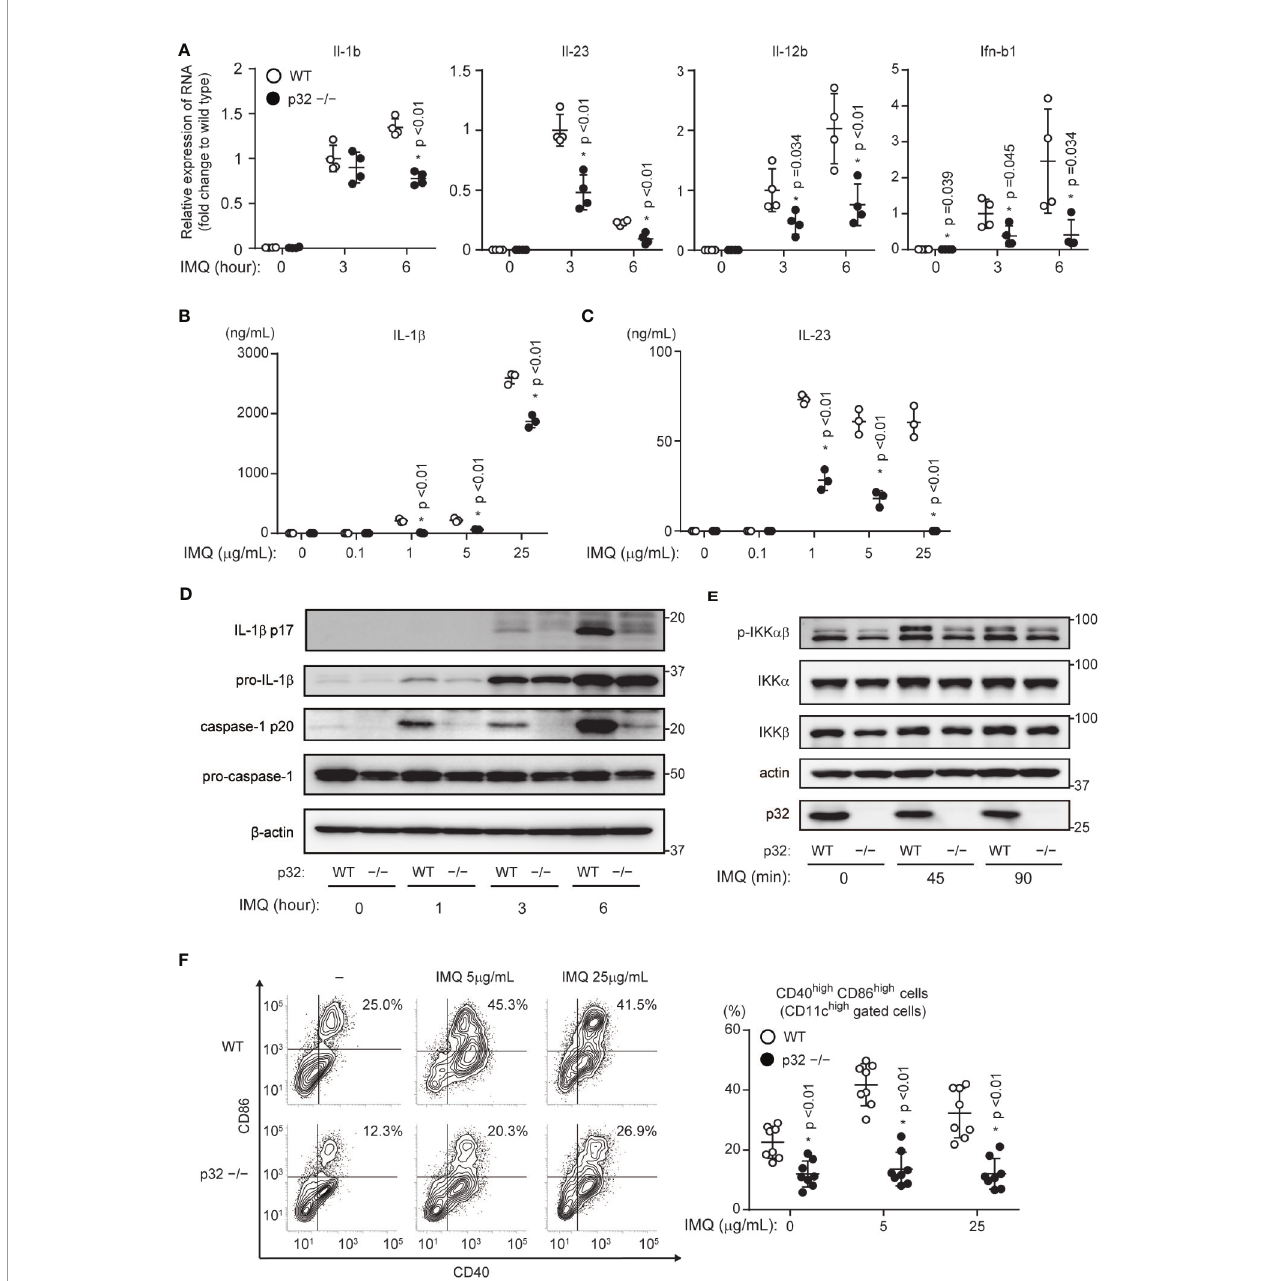
FIGURE 3 | Roles of p32/C1qbp in vitro . (A) Real-time PCR analyses of Il-1b, Il-23, Il-12b, and Ifnb1 expression levels in WT and p32 − / − DCs stimulated with 5 m g/ mL IMQ for the indicated intervals. Data are shown as means ± SEMs after normalization to expression of the gene encoding 18S ribosomal RNA (18S rRNA). (B, C) Levels of IL-1 b (B) and IL-23 (C) in cell culture supernatants were compared between WT and p32 − / − BMDCs (2×10 5 cells/well) after 24 h of stimulation with IMQ. Data are shown as means ± SDs of triplicate wells. (D, E) WT and p32 − / − DCs were stimulated with 5 m g/mL IMQ for the indicated intervals and analyzed for IL-1 b p17, caspase-1 p20 (D) , and phosphorylation of IKK- ab (E). b -Actin was used as an internal control. (F) Expression levels of cell surface markers of CD86 and CD40 in WT (upper) and p32 − / − (lower) BMDCs left untreated ( − ) or stimulated for 12 h with IMQ and analyzed using fl ow cytometry to quantify cell surface staining of CD86 and CD40. Numbers in top right corners indicate the percentages of CD86 + CD40 + cells. Data are representative of two (A) and three (B – F) independent